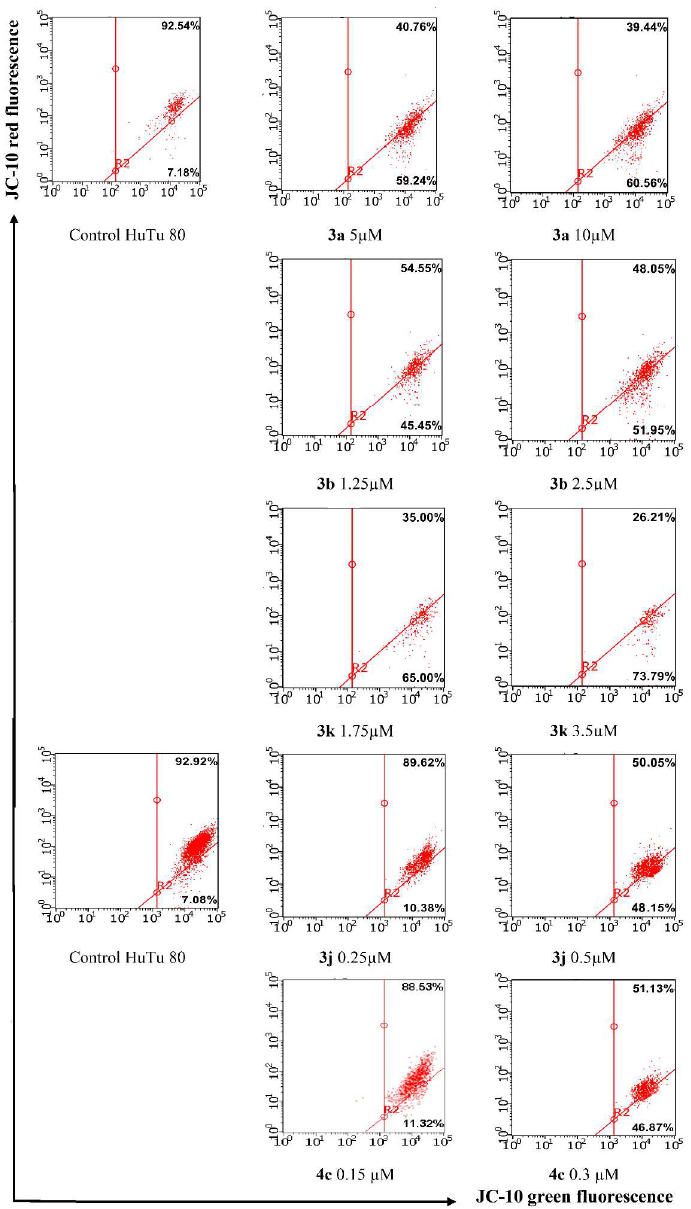
Figure 5. Flow cytometry analysis of HuTu-80 cells treated with compounds 3a , b , k , j and 4c at the concentrations of IC 50 /2 and IC 50 in μM for 48 h.